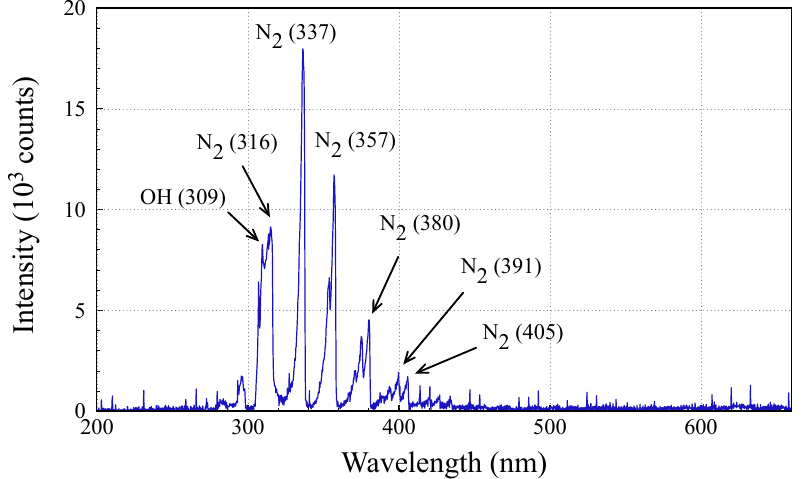
Figure 6. Optical emission spectrometry (OES) spectra of AALCA.